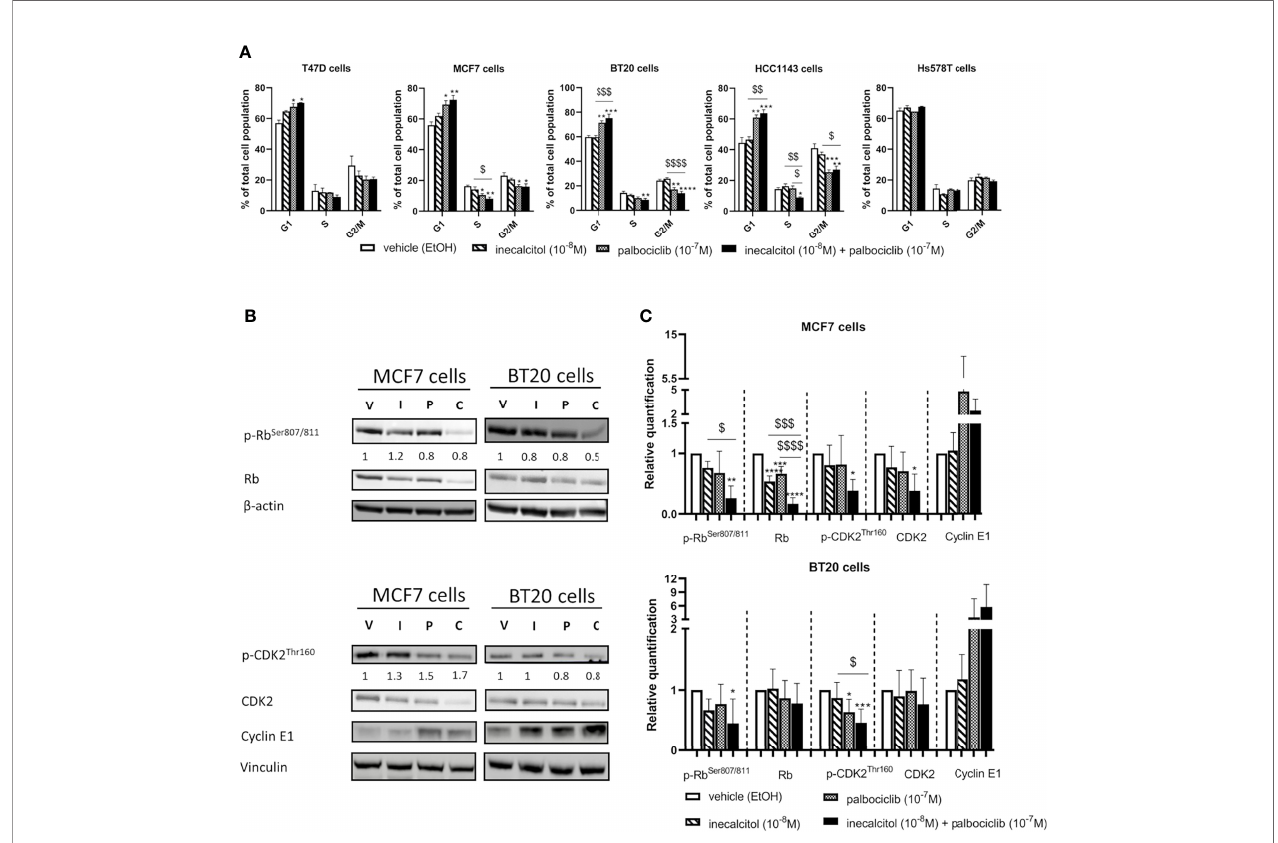
FIGURE 3 | Effect of inecalcitol and/or palbociclib treatment on cell cycle regulation. (A) PI FACS analysis showed the number of cells in the different phases of the cell cycle in all investigated cell lines after treatment with vehicle (EtOH, 72 h), inecalcitol (10 -8 M, 72 h), palbociclib (10 -7 M, 72 h) or the combination of both (72 h) (n=2-5 performed in duplicate). Data shown as mean ± SEM. (B) Protein expression of (p)-Rb (110 kDa), (p)-CDK2 (33 kDa) and Cyclin E1 (48 kDa) in MCF7 and BT20 cells after 72 h treatment (one representative blot shown). The ratio of phosphorylated to non-phosphorylated relative protein expression is indicated under the representative blot. Data are expressed as fold increase vs control (control value = 1). (C) Relative quanti fi cation of protein levels of (p)-Rb, (p)-CDK2 and Cyclin E1 in MCF7 and BT20 cells (n=4-6). b -actin (42 kDa) and vinculin (124 kDa) were used as loading control. V = vehicle (EtOH), I = inecacitol (10 -8 M), P = palbociclib (10 -7 M) and C = combination of inecalcitol (10 -8 M) and palbociclib (10 -7 M). Data shown as mean ± SD. *p ≤ 0.05; **p ≤ 0.01; ***p ≤ 0.001; ****p ≤ 0.0001 compared to vehicle; $ p ≤ 0.05; $$ p ≤ 0.01; $$$ p ≤ 0.001; $$$$ p ≤ 0.0001 compared to inecalcitol or palbociclib monotherapy (one-way ANOVA, Sidak ’ s multiple comparison